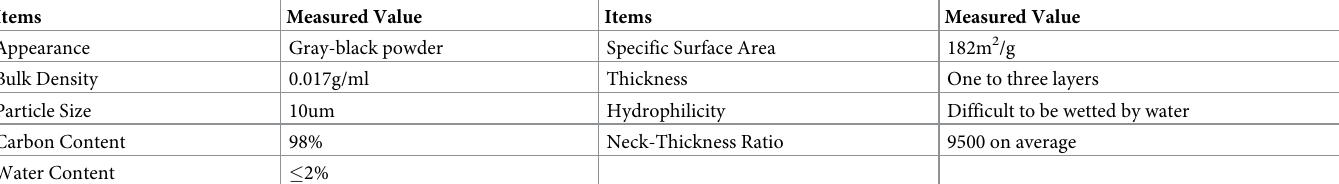
Table 2. The main technical performance of graphene oxide. Items